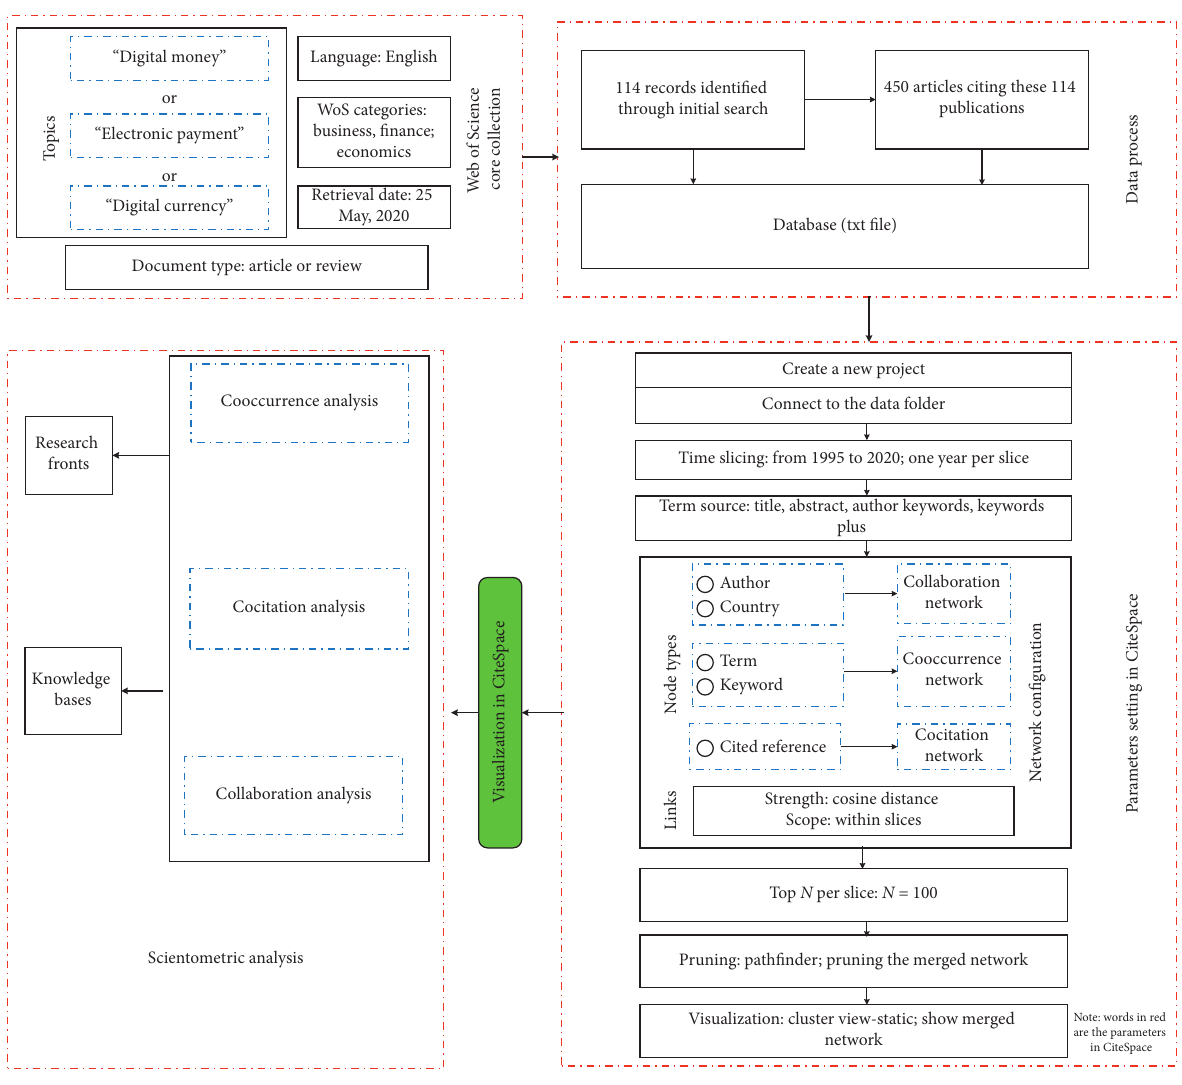
Figure 3: Framework of this